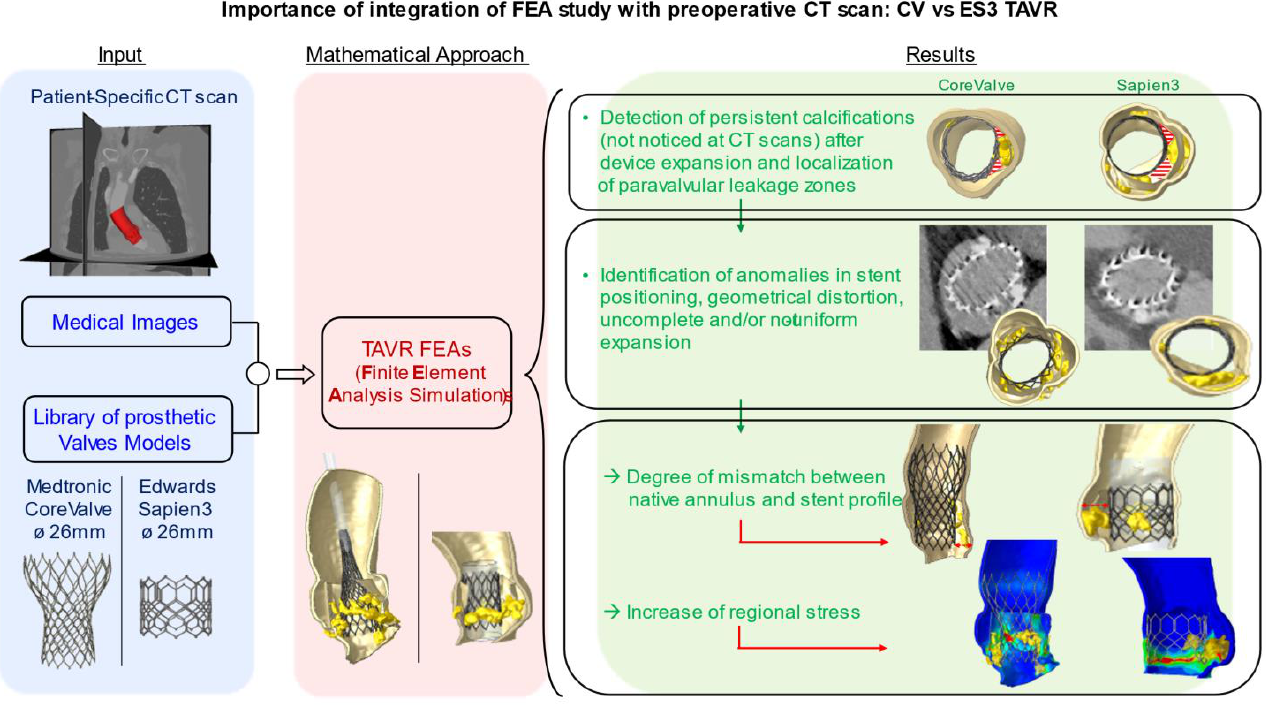
Figure 1. The integration of preoperative medical images with FEA simulation can describe the impact of uncrushed calcifications on TAVR complications. These studies could be useful in predicting potential risk factors.